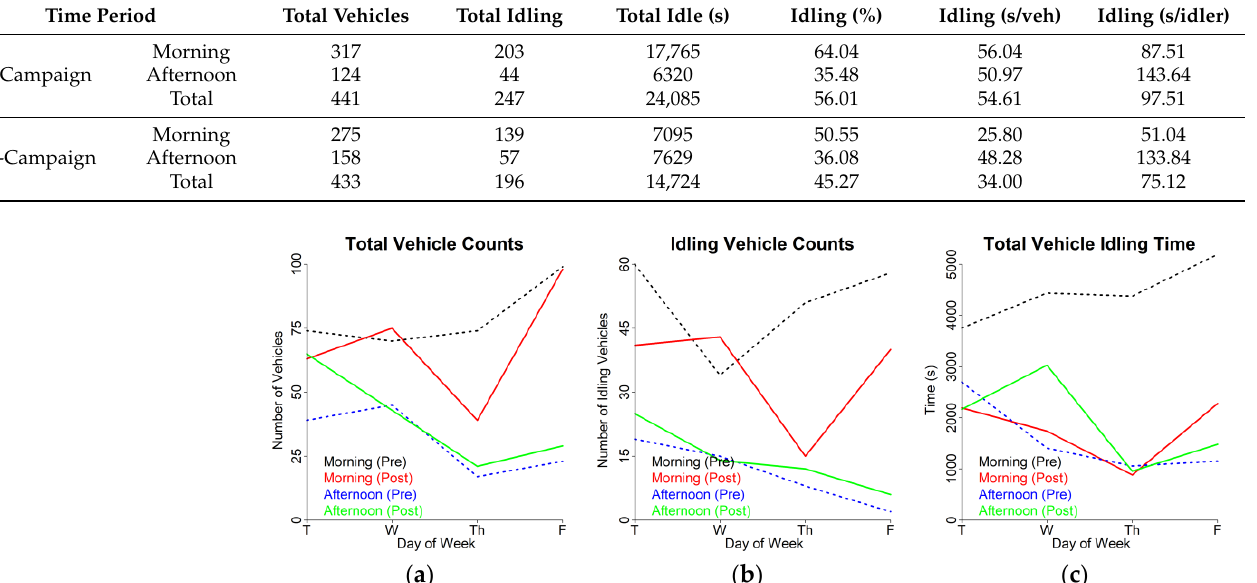
Table 10. Bonneville Elementary Idle-Free Campaign aggregated and average values.